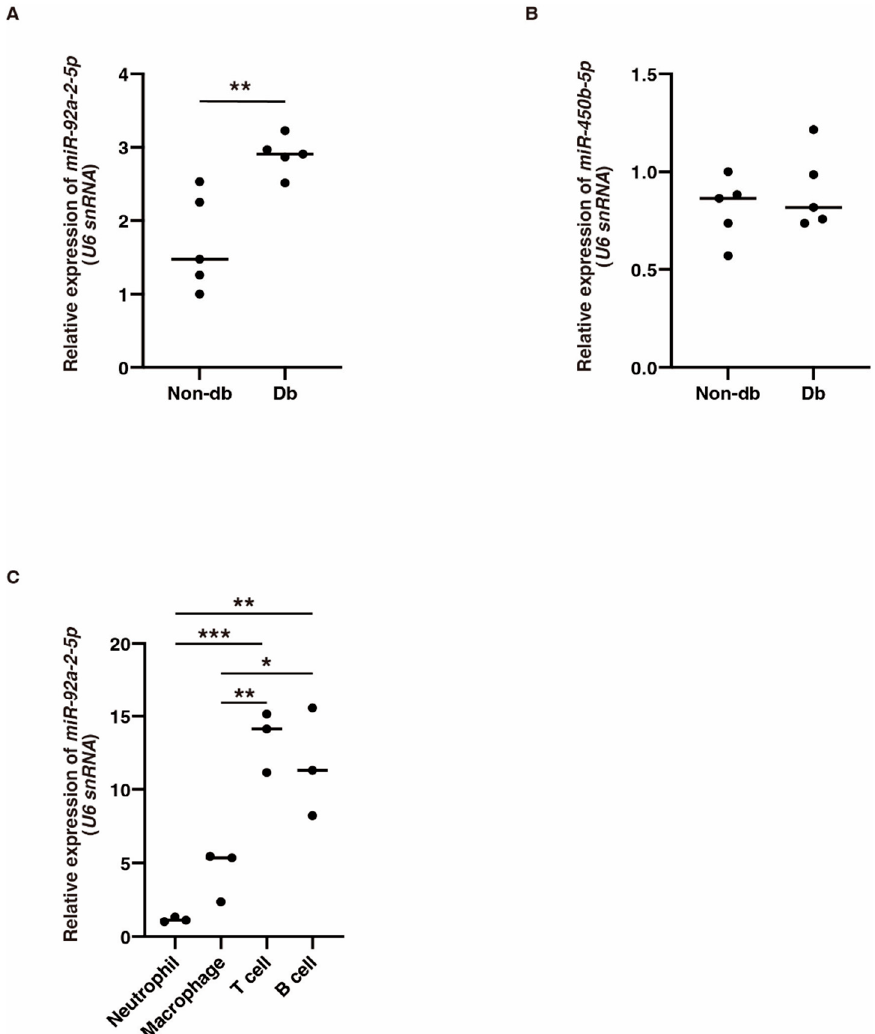
Figure 3. The expression of miR-92a-2-5p and miR-450b-5p in diabetic-derived neutrophils and miR- 92a-2-5p in T and B cells . ( A , B ). Relative expression of miR-92a-2-5p and miR-450b-5p in Db. Graphs show mean ± SD ( n = 5). The statistical significance of differences between means was assessed by unpaired t-test. ** p < 0.01. ( C ). Relative expression of miR-92a-2-5p in neutrophils, macrophages, T cells, and B cells isolated from BM from non-db mice. miR-92a-2-5p is mainly expressed in T cells and B cells. Graphs show mean ± SD ( n = 3). The statistical significance of differences between means was assessed by one-way ANOVA, followed by Tukey’s multiple comparison test. * p < 0.05; ** p < 0.01; *** p < 0.001.